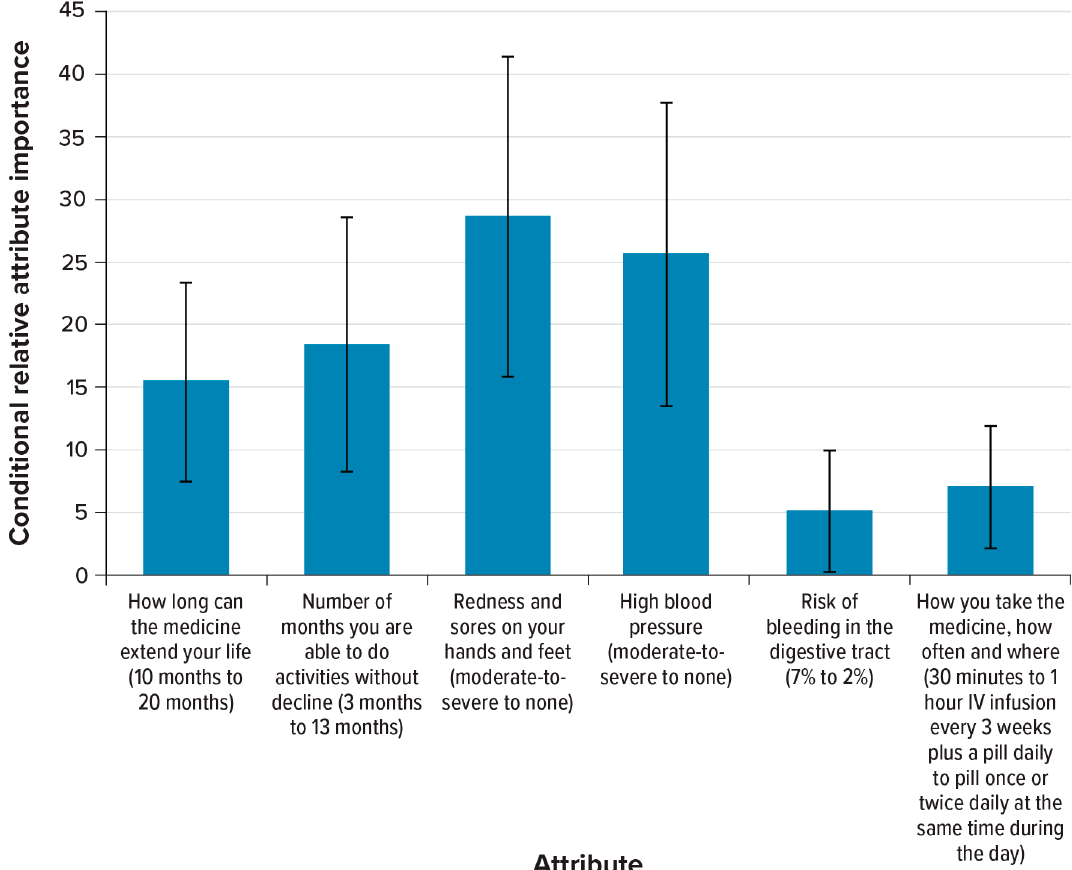
Figure 2. Conditional relative importance of attributes for respondents (N = 200). IV = intravenous. Note: The conditional relative importance is the difference between the most-preferred and least- preferred preference weights. These differences are summed across attributes, and this sum is scaled to 100. The conditional importance of each attribute is a percentage of this sum total. The vertical bars surrounding each relative importance weight estimate indicate the 95% confidence interval around the point estimate, computed by the delta method.